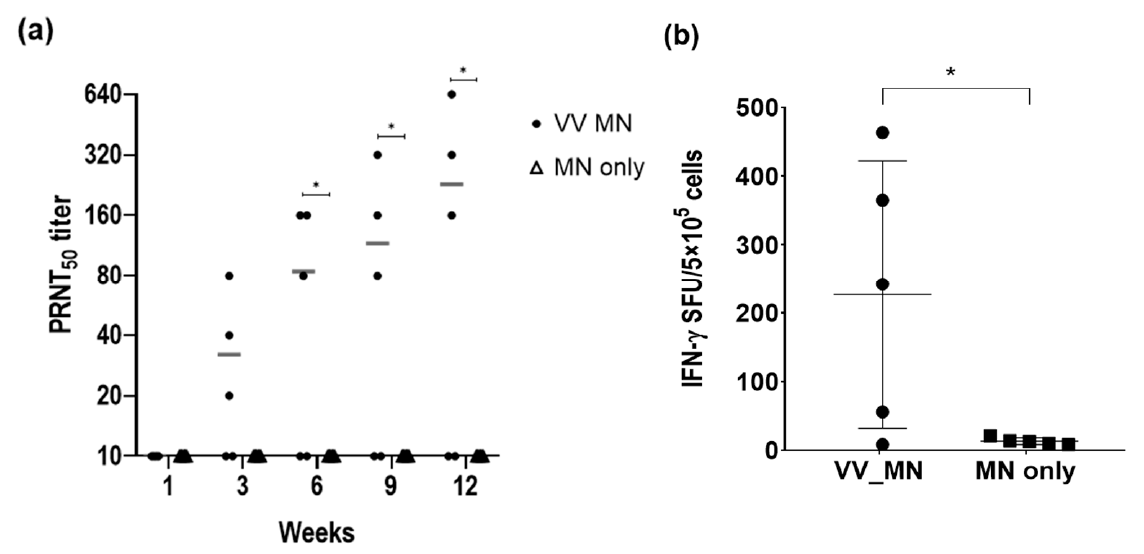
Figure 6. Humoral and cell-mediated immune responses after vaccination using microneedles. ( a ) PRNT50 titer of neutralizing antibody against the vaccinia virus, and ( b ) interferon (IFN)- γ -secreting cells were evaluated using the enzyme-linked immunospot (ELISPOT) assay for analyzing T-cell-mediated immune response. Horizontal bars in each graph indicate geometric mean titer. Statistical significance compared to MN only group was determined by a t -test (* p < 0.05). PRNT, plaque reduction neutralisation test; SFU, spot forming unit.